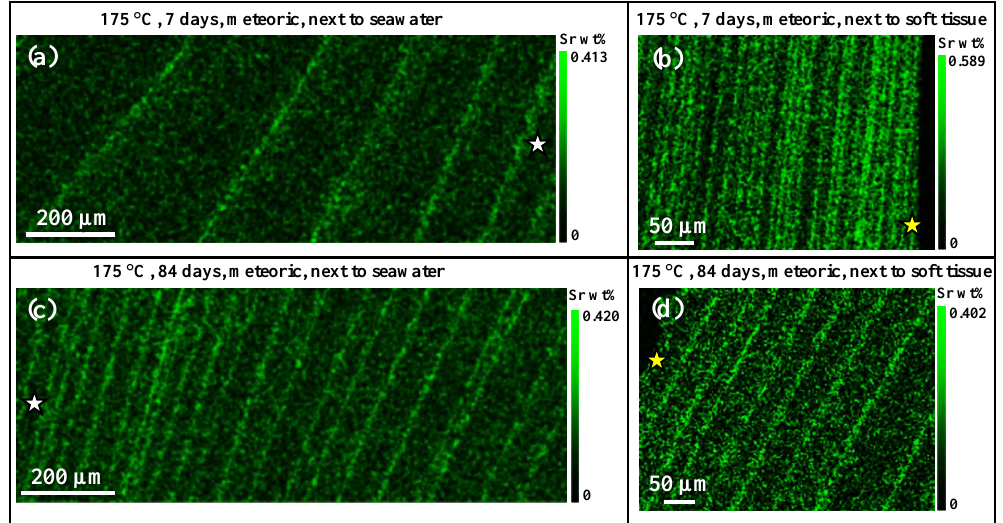
Figure A6. Sr 2 + concentrations along annual growth lines in hydrothermally altered Arctica islandica shell portions. Alteration temperature was 175 ◦ C, meteoric water was used as alteration fluid, and the alteration experiments lasted for 7 and 84 days (a–b) . Sr 2 + concentration scatters for both alteration times around 0.4wt% Sr 2 + and is similar to the value measured in the pristine Arctica islandica reference samples (see Fig. A5a,